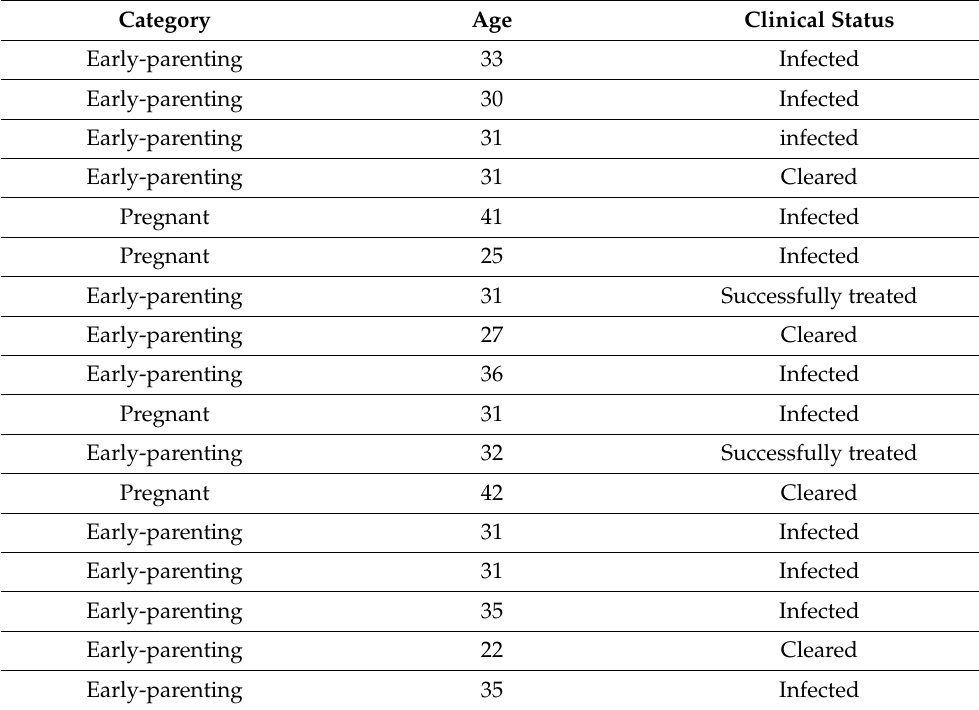
Table 1. Characteristics of study